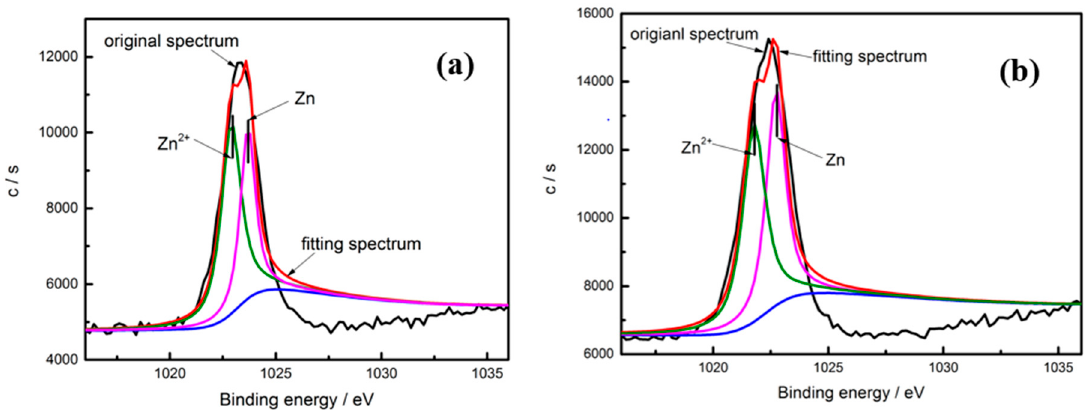
Figure 6. XPS spectrum for Zn2p 3/2 obtained from Sn–8Zn–3Bi solder alloy in 3.5 wt.% NaCl solution at room temperature: ( a ) SC alloy; ( b ) RC alloy.